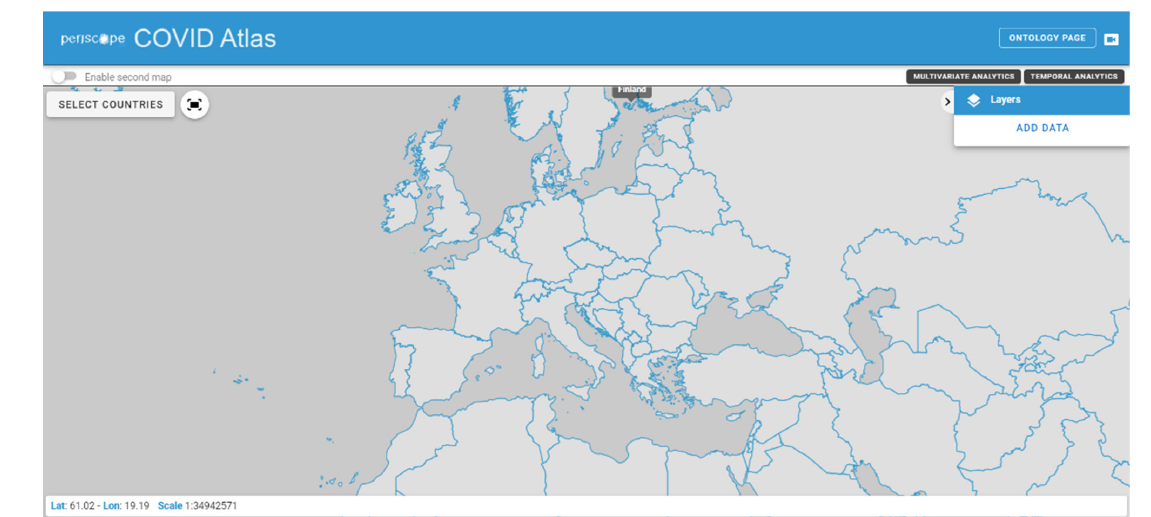
Figure 4. Initial Atlas interface.